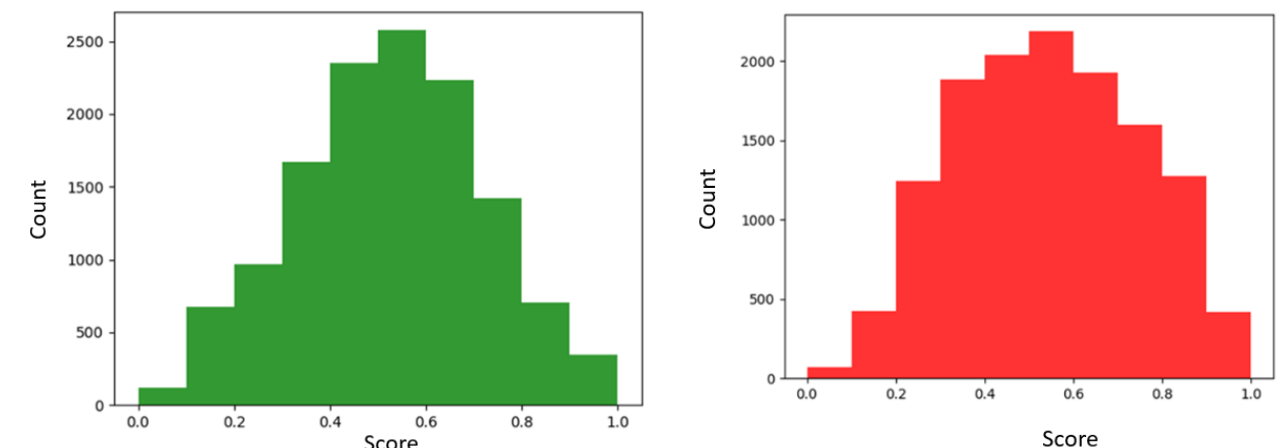
Figure 9. Transportation score using K-means ( left ) and graph theory ( right ).